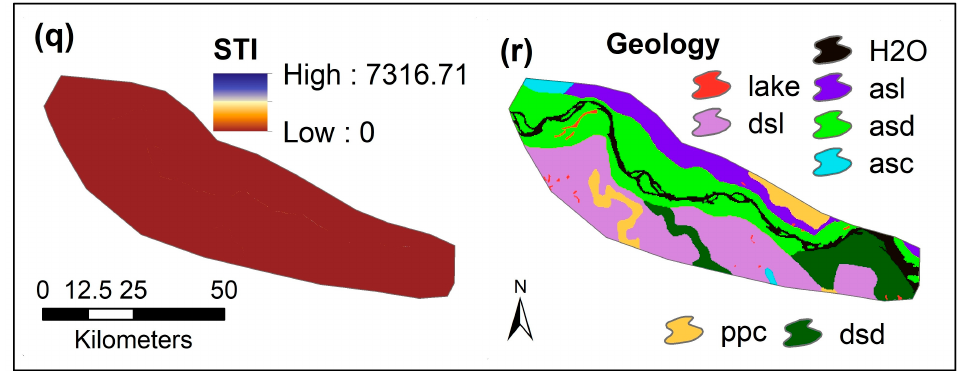
Figure 3. Flood susceptibility causal variables: ( a ) aspect, ( b ) elevation (m), ( c ) slope angle (degree), ( d ) curvature, ( e ) plan curvature, ( f ) profile curvature, ( g ) flow direction, ( h ) flow accumulation, ( i ) land use and land cover (LULC), ( j ) normalized difference vegetation index (NDVI), ( k ) distance to the rivers (m), ( l ) soil, ( m ) mean annual rainfall (mm), ( n ) river density (RD), ( o ) stream power index (SPI), ( p ) topographic wetness index (TWI), ( q ) sediment transport index (STI), ( r ) geology.